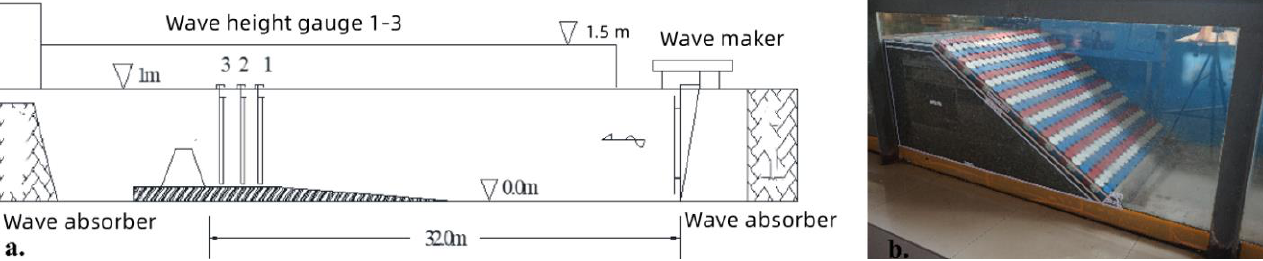
Figure 2. ( a ) Sketch of model layout; ( b ) Model photo with breakwater slope, m = 2.